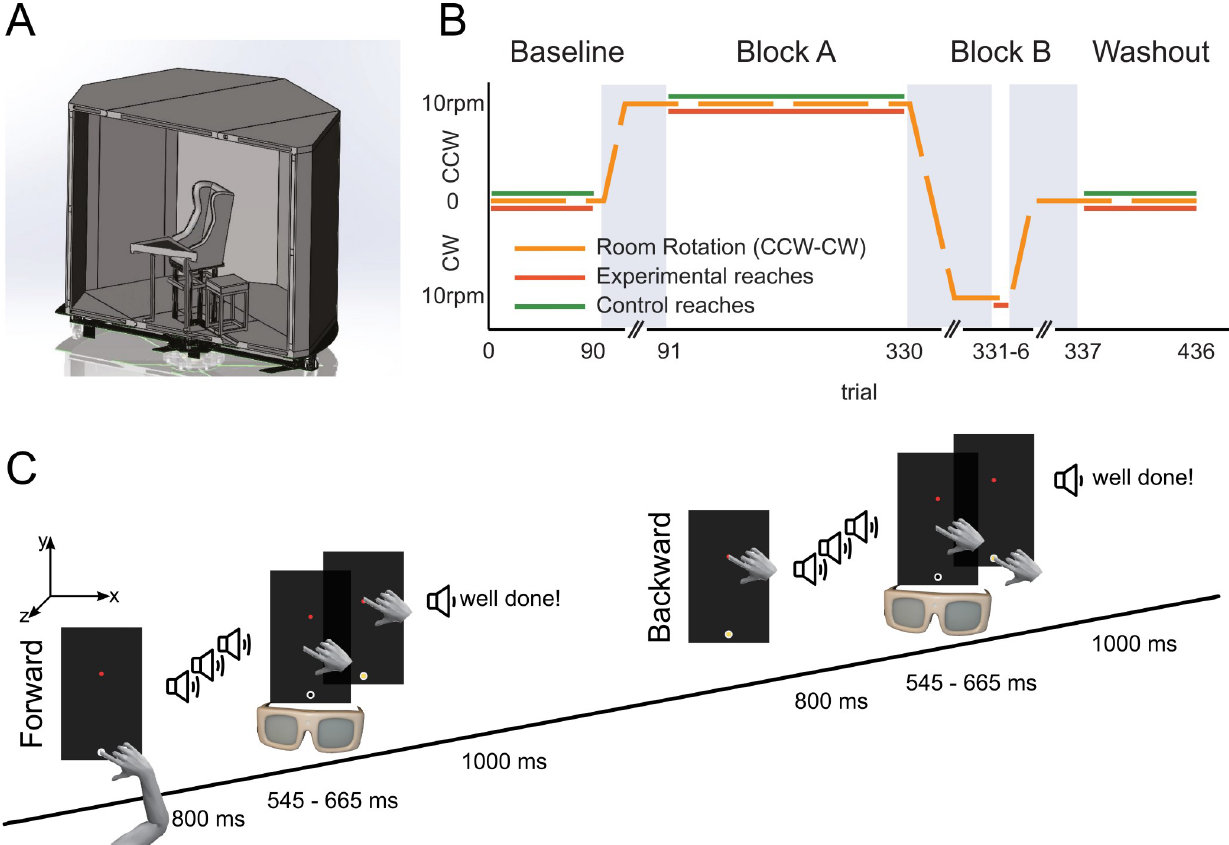
Fig 1. Experimental setup, paradigm and task. (A) Participants were seated in the center of a fully-enclosed rotating room and performed right-hand reaching movements to visual targets presented on a touch screen. (B) Experimental paradigm. Dark orange and green solid lines respectively indicate during which phases the experimental and control group made reaches. The dashed orange line indicates the rotation speed of the room. Grey areas indicate acceleration and deceleration of the rotating room and the time to let canal effects dissipate. (C) Temporal sequence of one trial pair (forward and backward movement). Reach is instructed by three auditory cues; vision is blocked during the